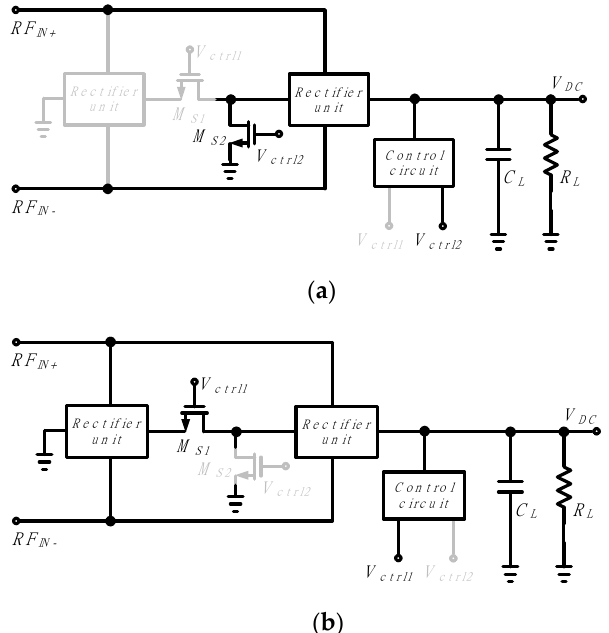
Figure 4. Operation of an adaptive RF–DC converter according to the input power: ( a ) Single-stage configuration at low input; ( b ) Series two-stage configuration at high input.